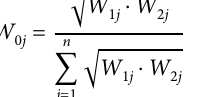
TABLE 3 | Transformer equivalent circuit parameters in relation to the faults. Changed parameter(s)